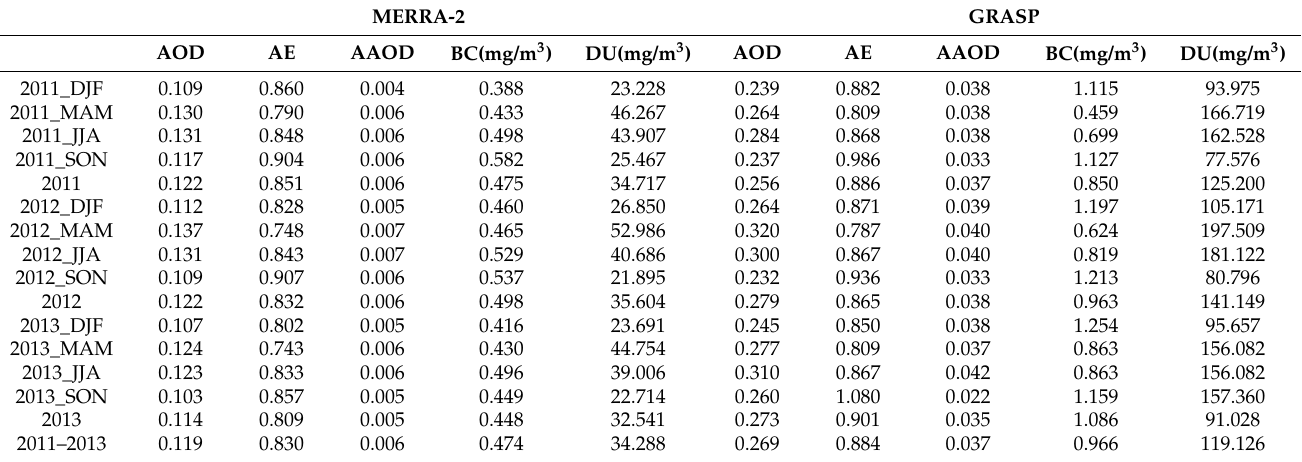
Table 3. The statistics mean of the seasonal values for MERRA-2 and GRASP from Jan 2011 to Dec 2013. MERRA-2